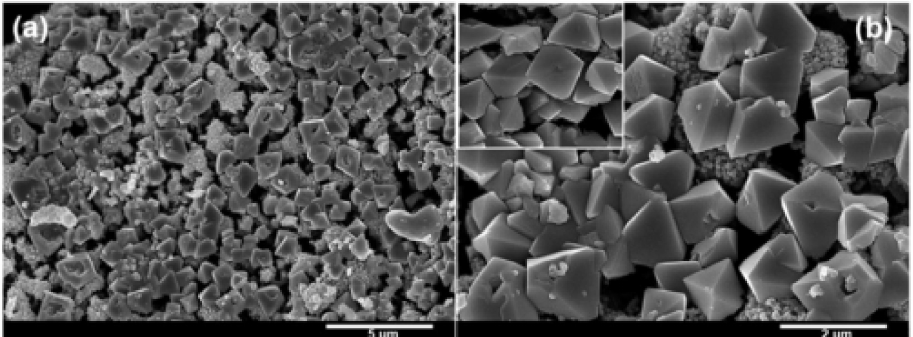
Figure 5. FESEM images at low ( a ) and high ( b ) magnification of the synthesized Fe 2 O 3 hexagonal cones. ( a , b ) Reproduced with the permission of ref. [45]. Copyright 2015, New Journal of Chemistry.